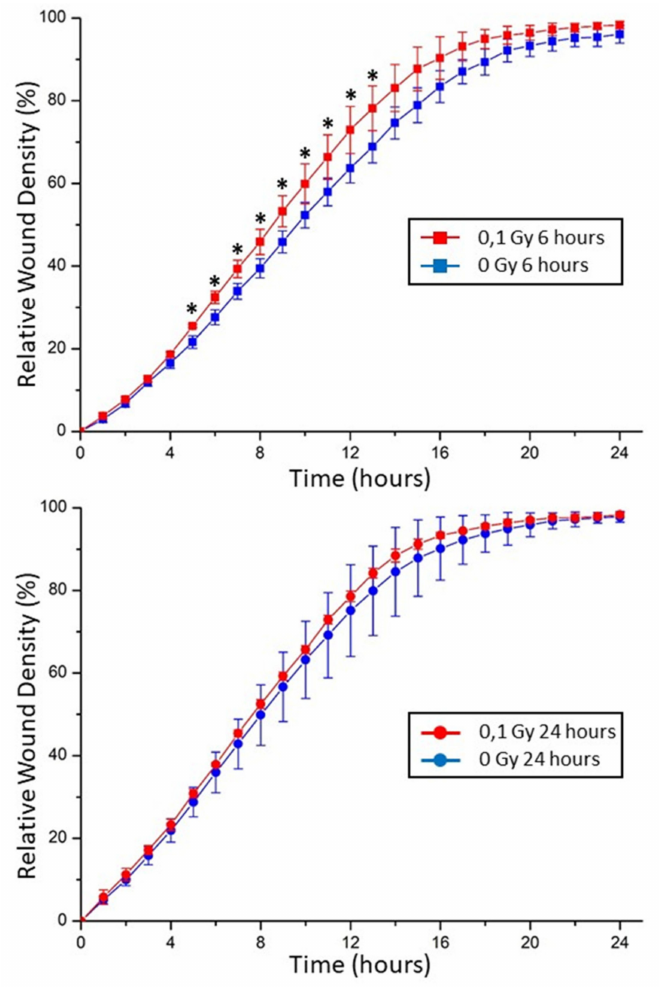
Figure 6. The conditioned medium of low-dose irradiated chondrosarcoma cells transiently increased the motility of T/C-28A2 bystander cells. Wound-healing assay showed the ability of cell migration in each group at 6 h ( top ) and 24 h ( bottom ) of contact with the conditioned media. (* = p <